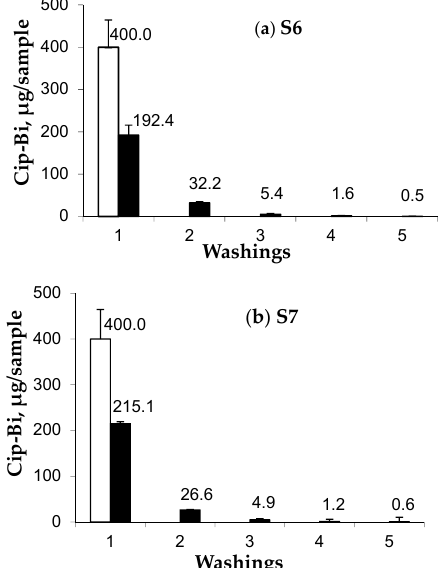
Figure 4. The amount of the ciprofloxacin-bismuth (Cip-Bi) introduced into the dressing sample (colorless bar) and released from the dressing sample (black bar). ( a ) S6—bromine-activated, Cip-Bi hydrogel-loaded dressing; ( b ) S7—iodine-activated, Cip-Bi hydrogel-loaded dressing.